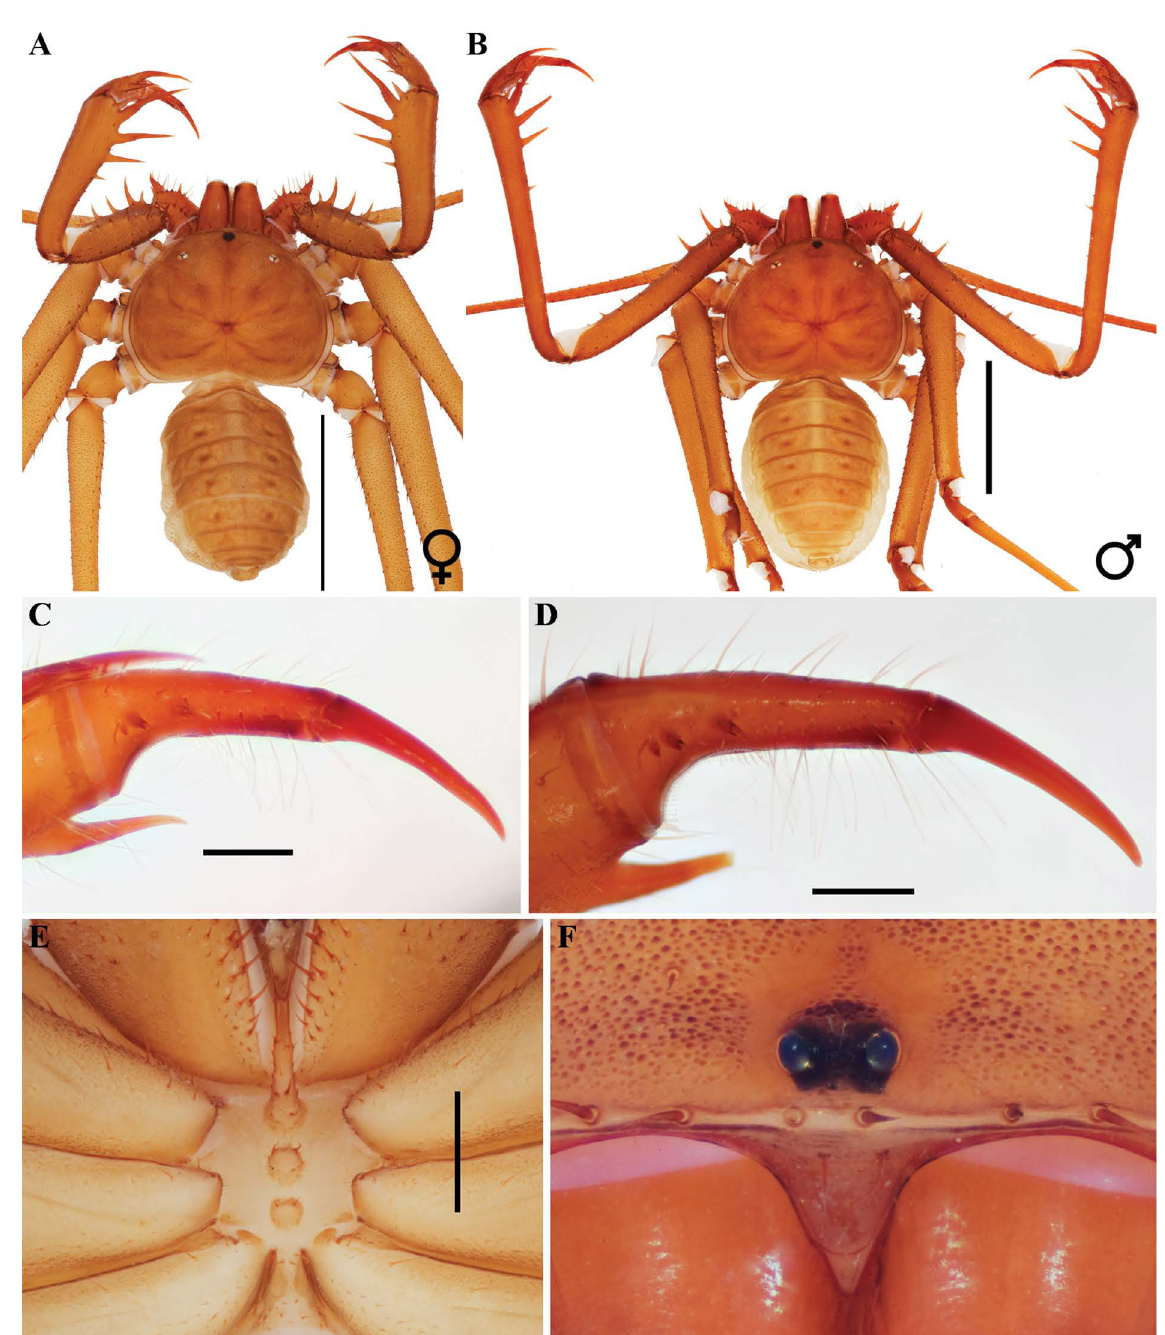
Fig. 61. Charinus euclidesi sp. nov. (MNRJ 9099), general morphology. A . Female habitus, dorsal view. B . Male habitus, dorsal view. C . Female pedipalp tarsal spines, dorsal view. D . Male pedipalp tarsal spines, dorsal view. E . Female sternum, ventral view. F . Male frontal process. Scale bars: A–B = 0.5 cm; C–D = 0.5 mm; E = 1 mm; F =